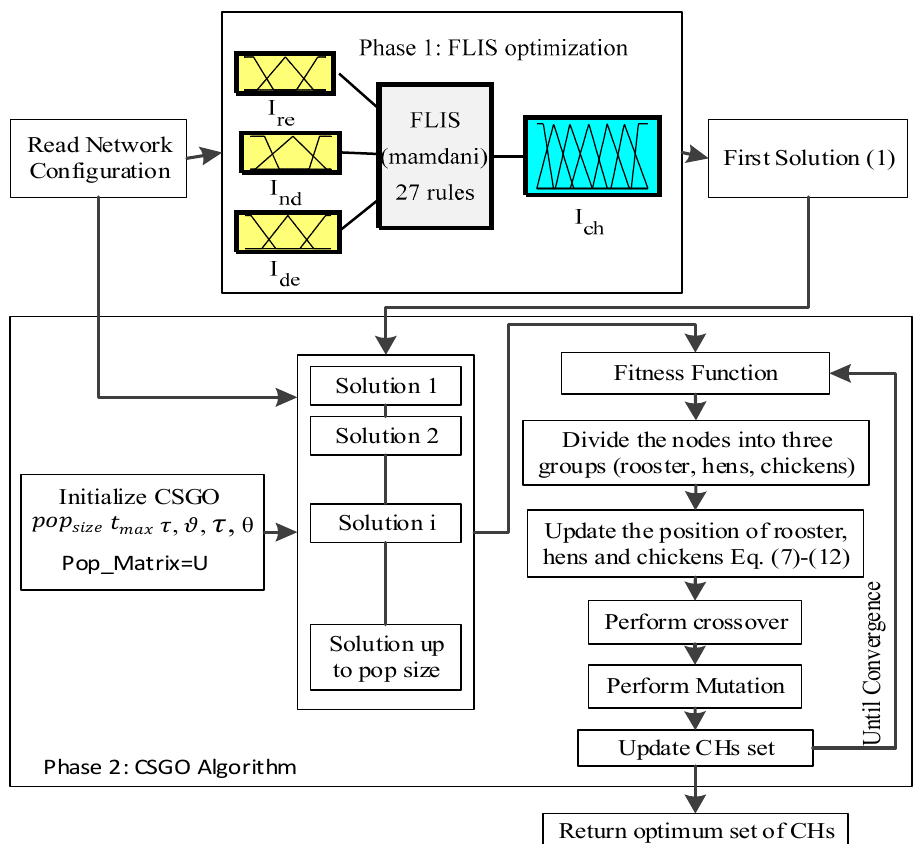
Figure 3. Workflow of the HIOA Algorithm.